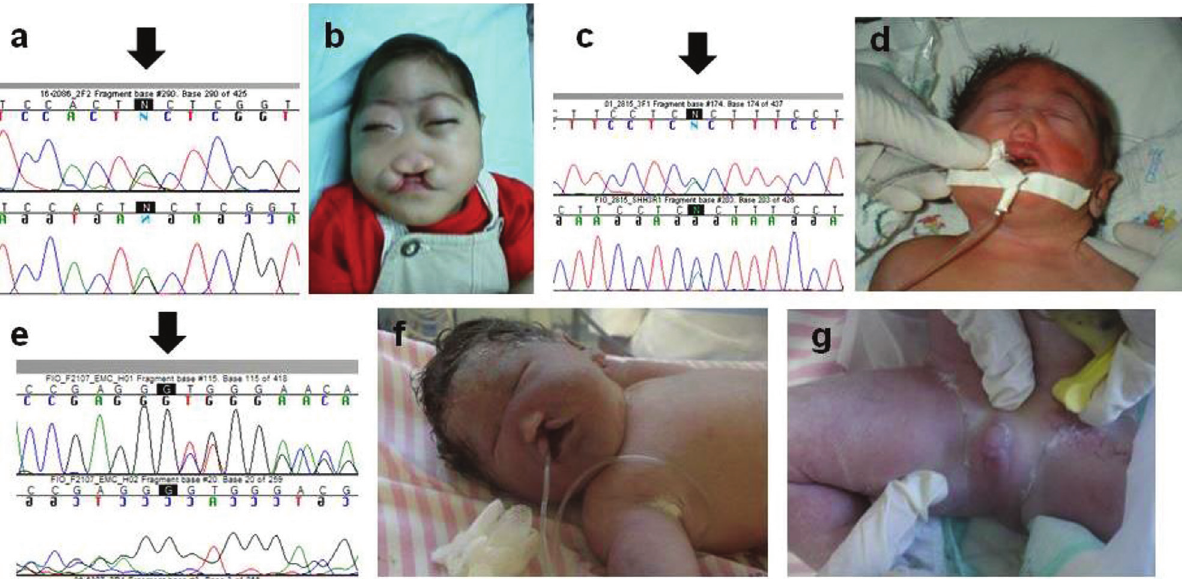
Figure 2 - HPE phenotypes and associated mutations. a) Missense mutation c.548G > A (p.C183Y) in exon 2 of SHH in patient ID 2086. b) Male patient (ID 2086) with microcephaly, ocular hypotelorism, small ocular fissures, and premaxillary agenesis. c) Missense mutation c.718A > C (p.T240P in the thirdexonof SHH inpatientID2815.d)Femalenewborn(ID2815)withmicrocephaly,ocularhypotelorism,singlenostrilandaccentuatedogivalpalate. e) Deletion (c.381delC) in the SHH gene in patient ID 5327, which alters the reading frame and generates a stop codon at 58 residues after the deletion. f) Male newborn (ID 5327) prenatally diagnosed as HPE and presenting single nostril, microphtalmia, ocular hypotelorism, median cleft lip, and microcephaly. g) Picture of patient ID 5327 showing micropenis and rudimentary scrotum with non-palpable